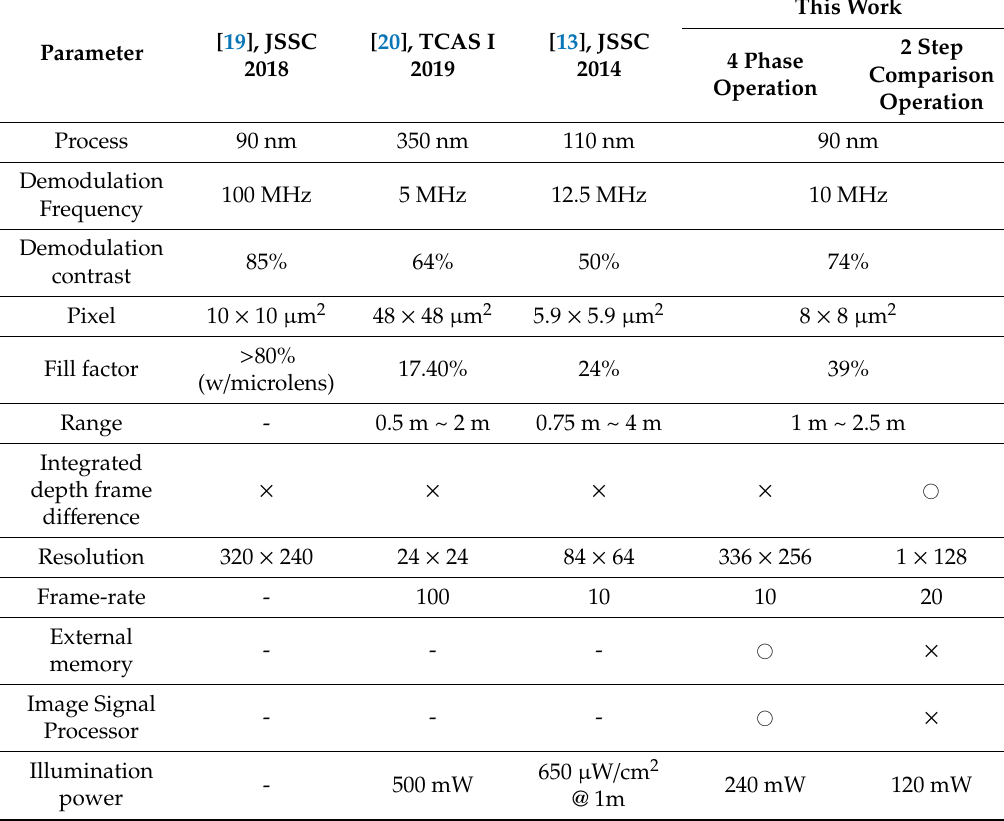
Table 2. Comparison of conventional depth sensors with a four-phase modulation